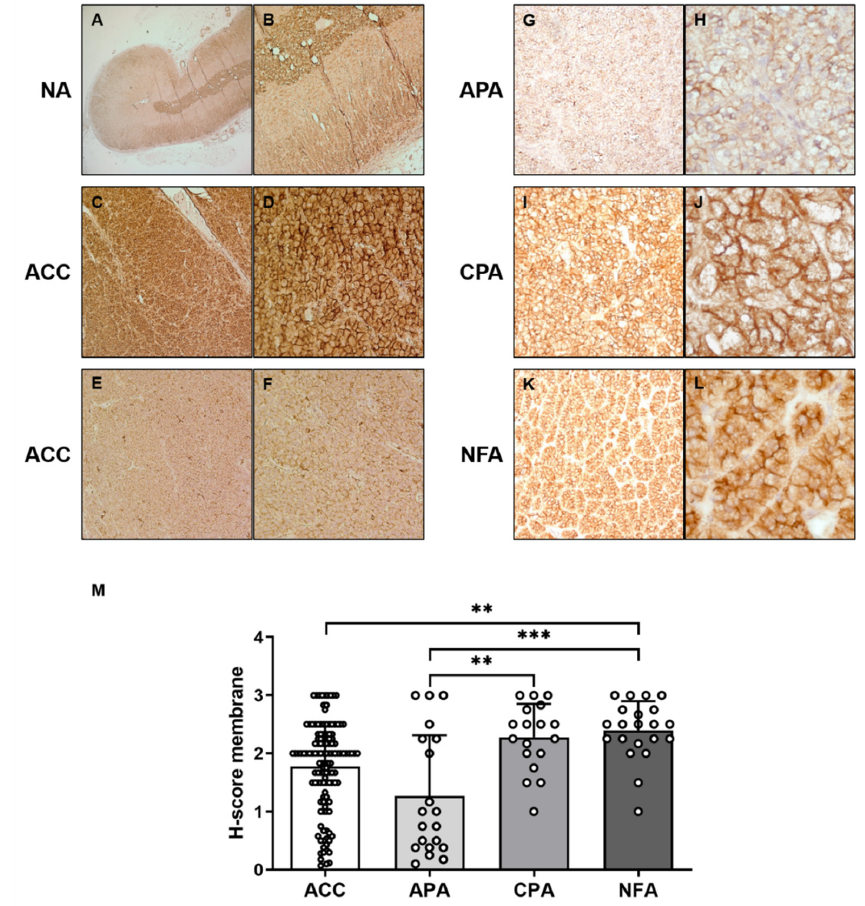
Figure 1. Representative immunohistochemical staining for CCR7 in the normal adrenal gland (NA). ( A ) 2.5 × +, ( B ) 10 × , adrenocortical carcinoma, ( C ) 10 × +, ( D ) 40 × , ( E ) 10 × +, ( F ) 40 × ),